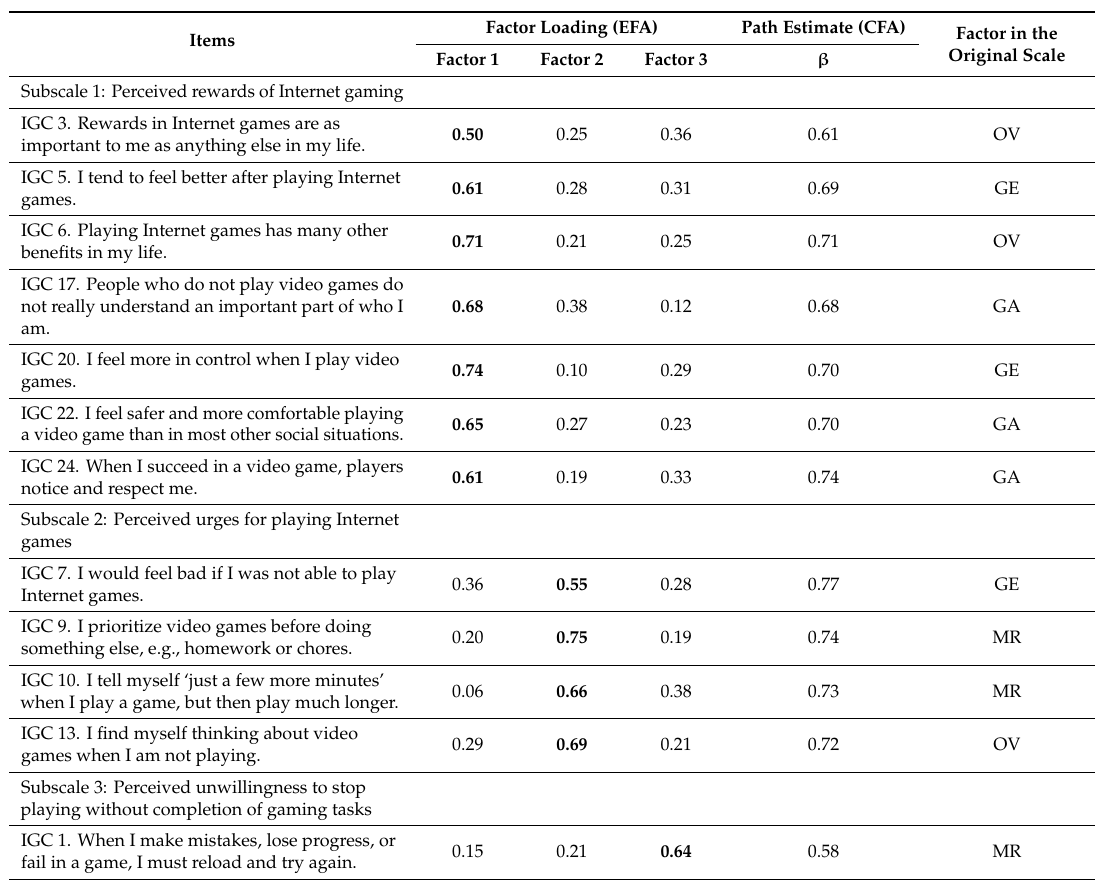
Table 3. Exploratory and confirmatory factor analyses of the Chinese version of revised Internet Gaming Cognition Scale. Factor Loading (EFA) Path Estimate (CFA) Factor in the Items